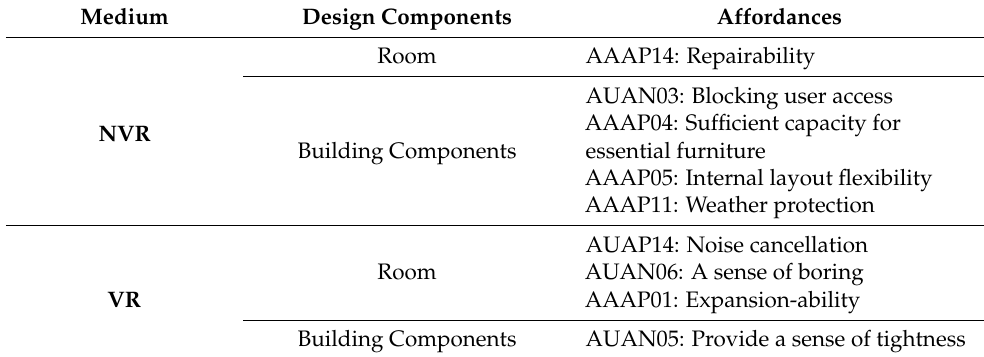
Table 15. List of affordances perceived on both design options of LC and APT